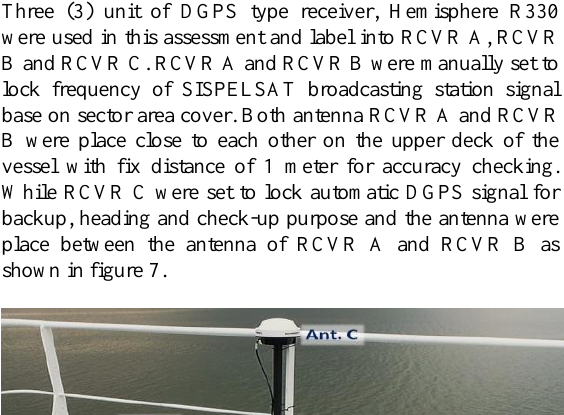
Figure 8. Methodology chart for performance assessment